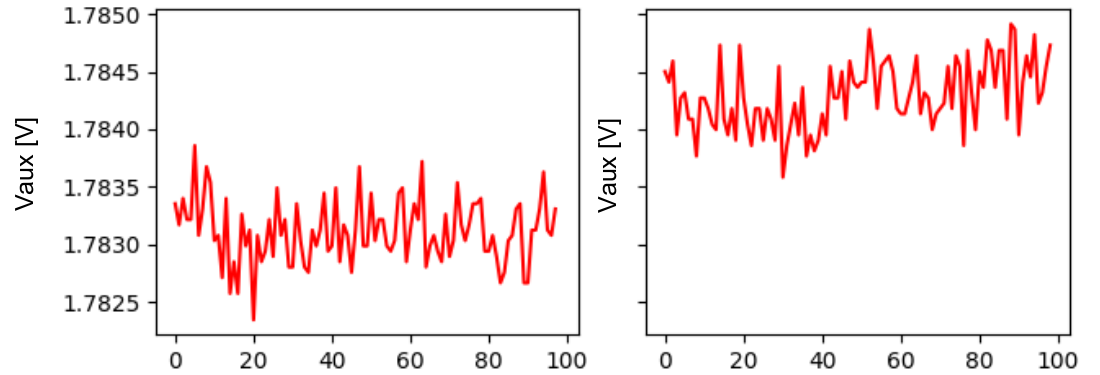
Figure 13. Comparison of the Vaux tension measurements of a 5€ banknote on reverse back orien- tation in the case of normal operation ( left ) and a failure case ( right ).